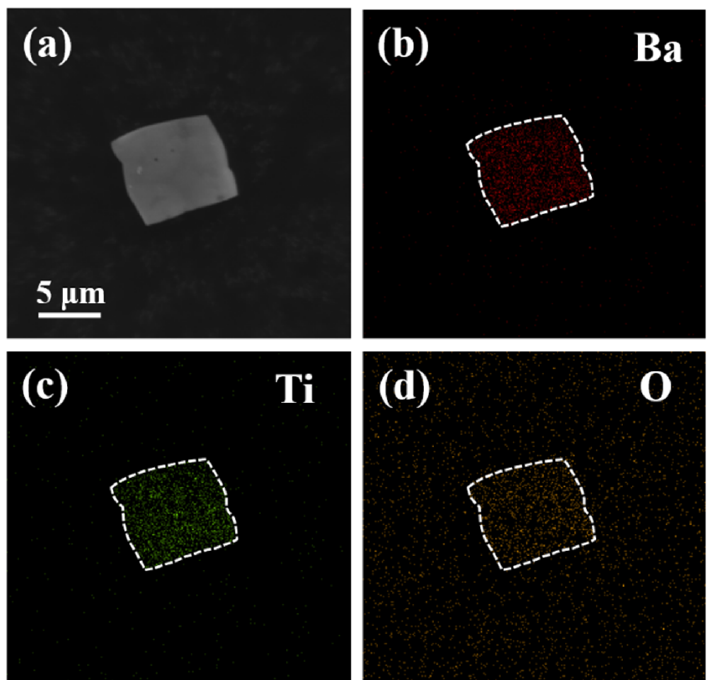
Figure 4. The EDS mapping results of the BaTiO 3 plates synthesized at 950 °C. ( a ) The FE-SEM image of the scanning area of EDS mapping includes a single BaTiO 3 plate. The distribution of ( b ) Ba ele- ment, ( c ) Ti element, and ( d ) O element in the scanning area.